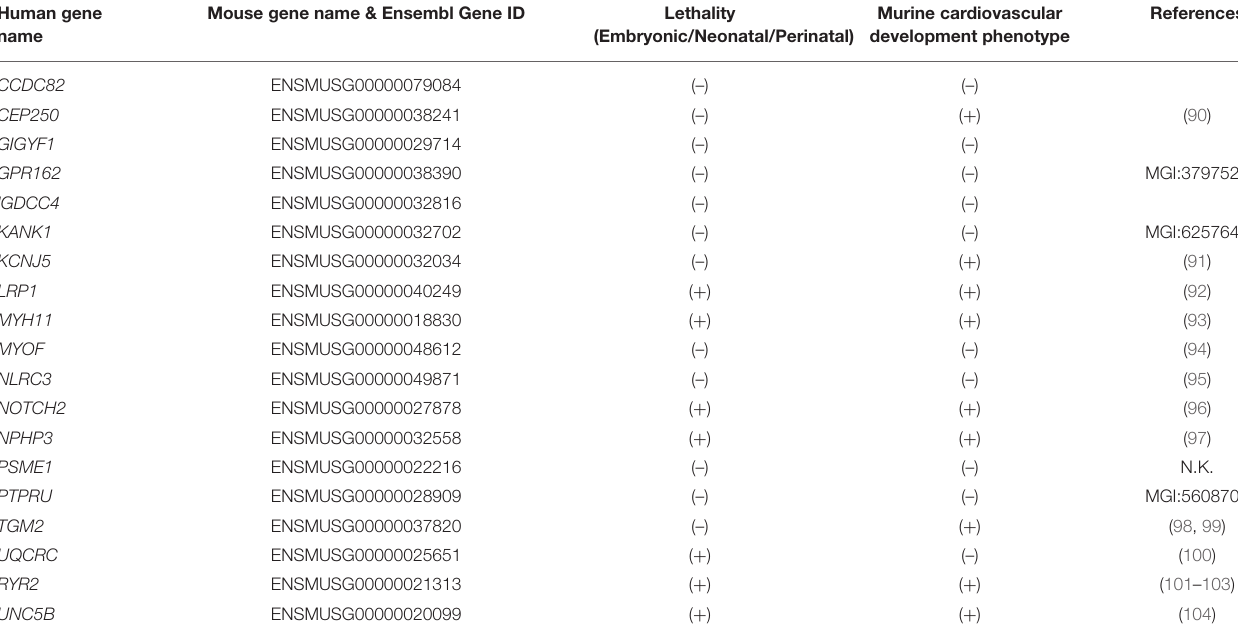
TABLE 2 | Overlap between DEG-HH and SLV-DN-MH gene